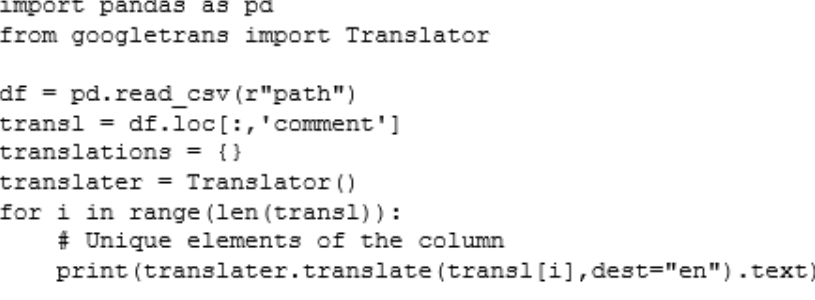
Figure 7. Code snippet for the comments ’ translation into English language [41] .